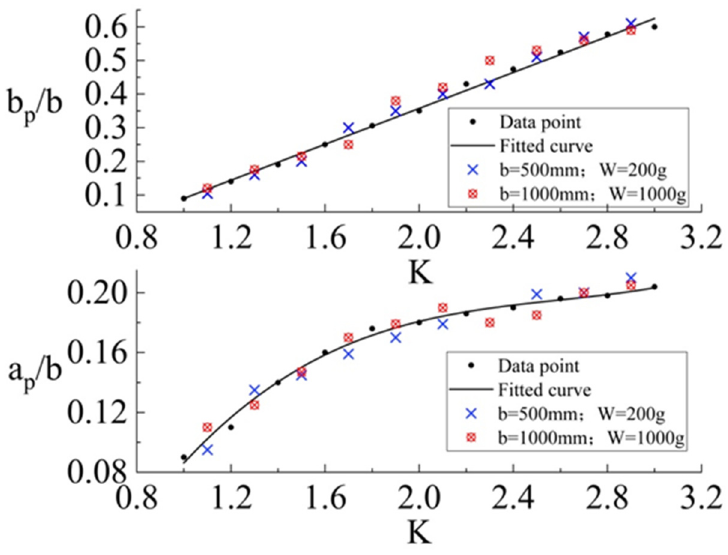
Figure 15. Relationship between the size of the high-pressure area and K